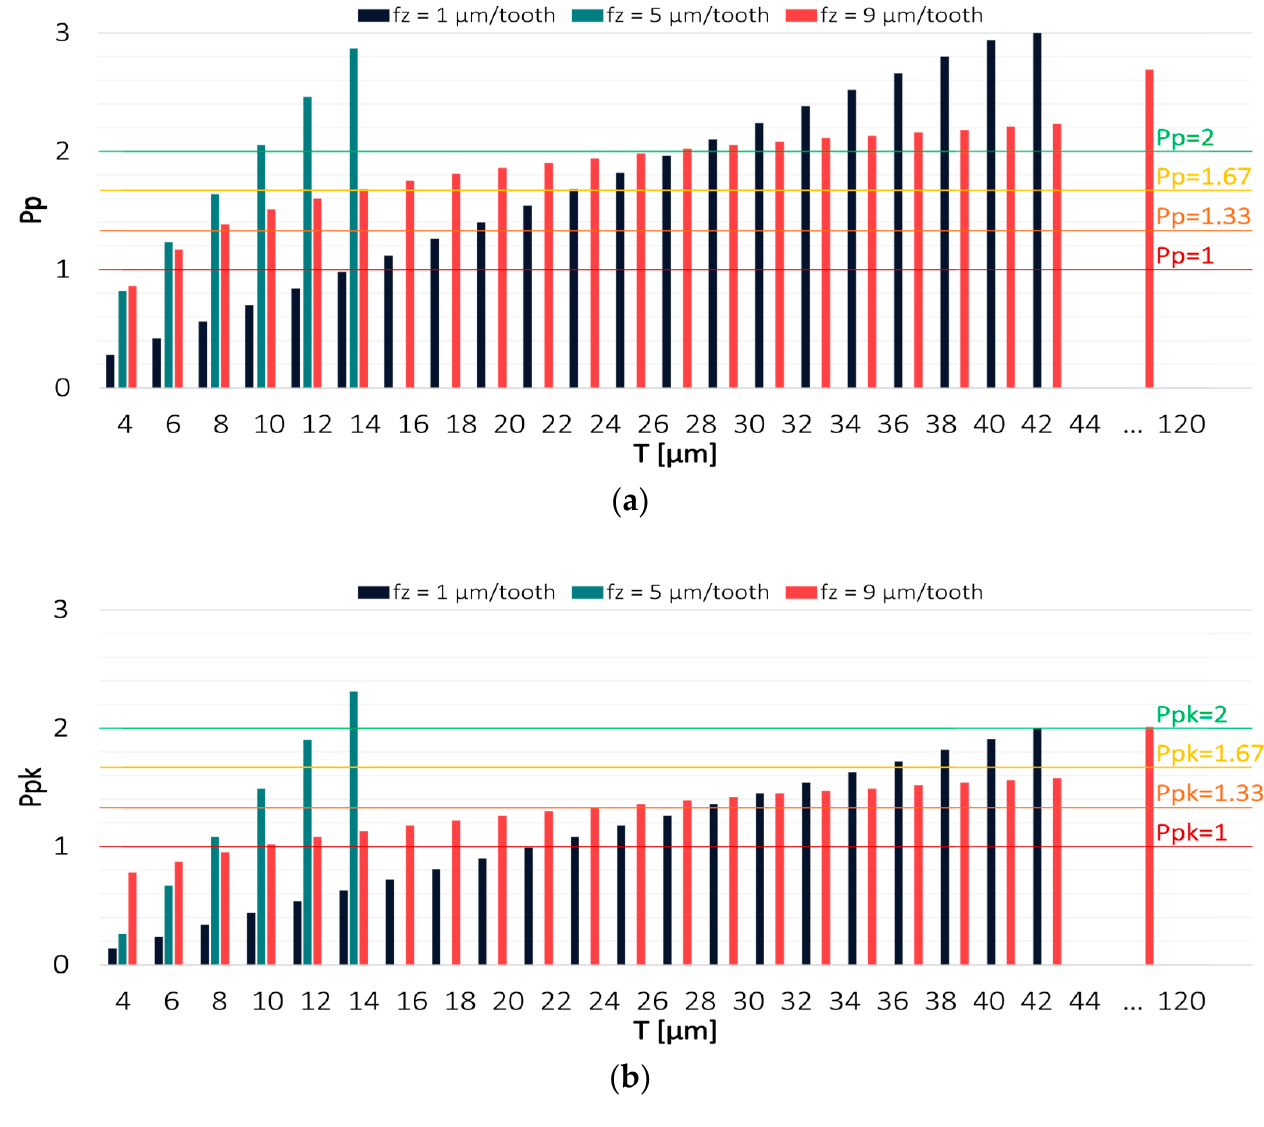
Figure 6. Values of ( a ) Pp and ( b ) Ppk for the results obtained in a milling process conducted with variable feed per tooth and TiAlN-coated tool.